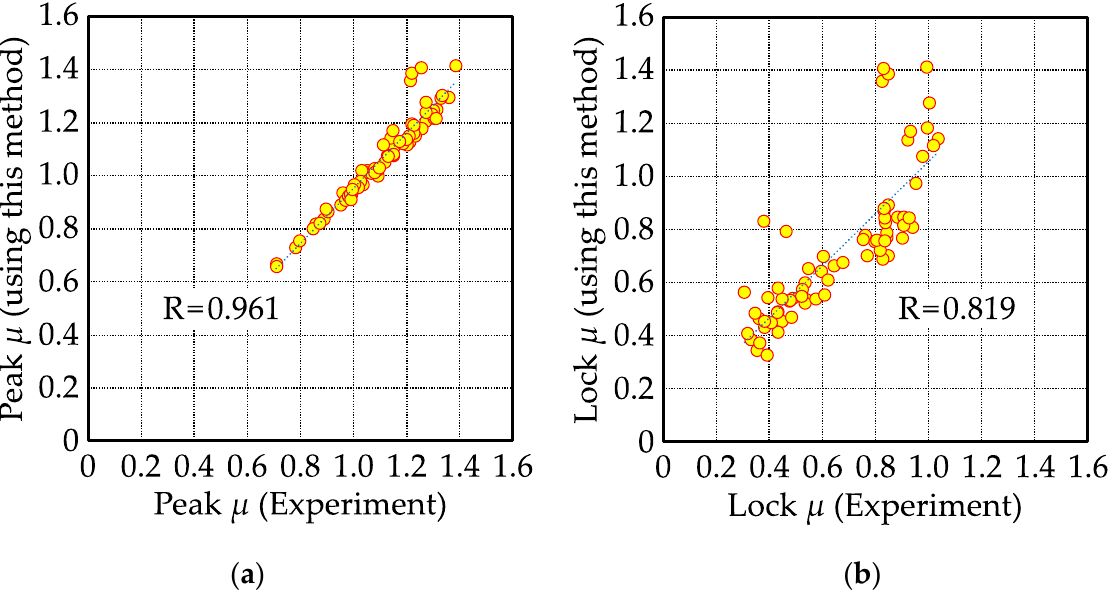
Figure 6. Results obtained with this method. ( a ) Comparison of the peak µ obtained by this analytical method and the results in Figure 1. ( b ) Comparison of the lock µ obtained by this analytical method and the results in Figure